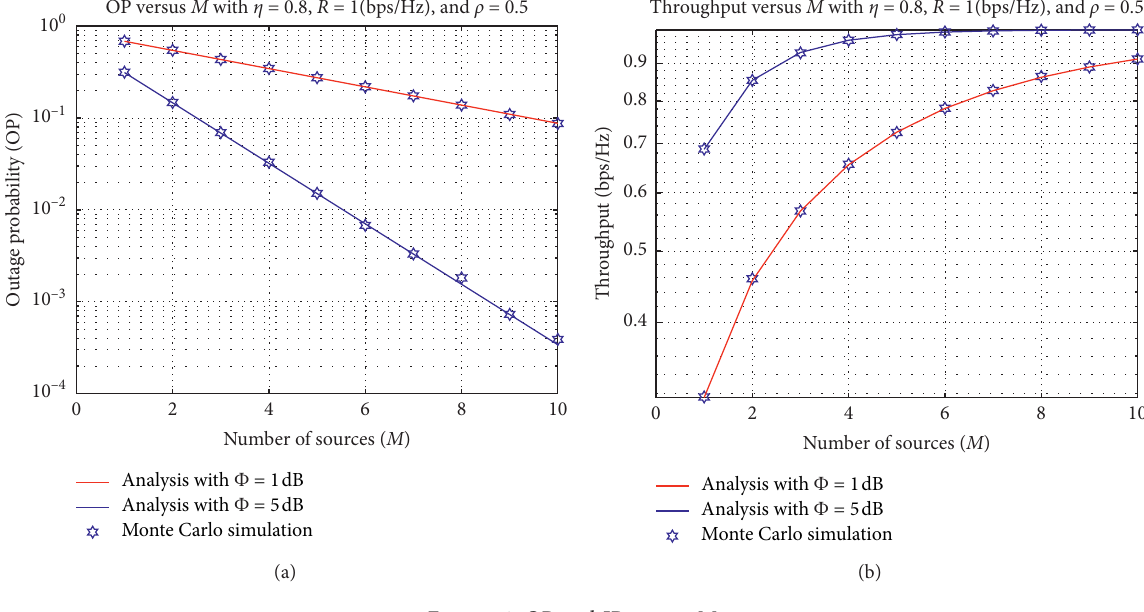
Figure 4: OP and IP versus M